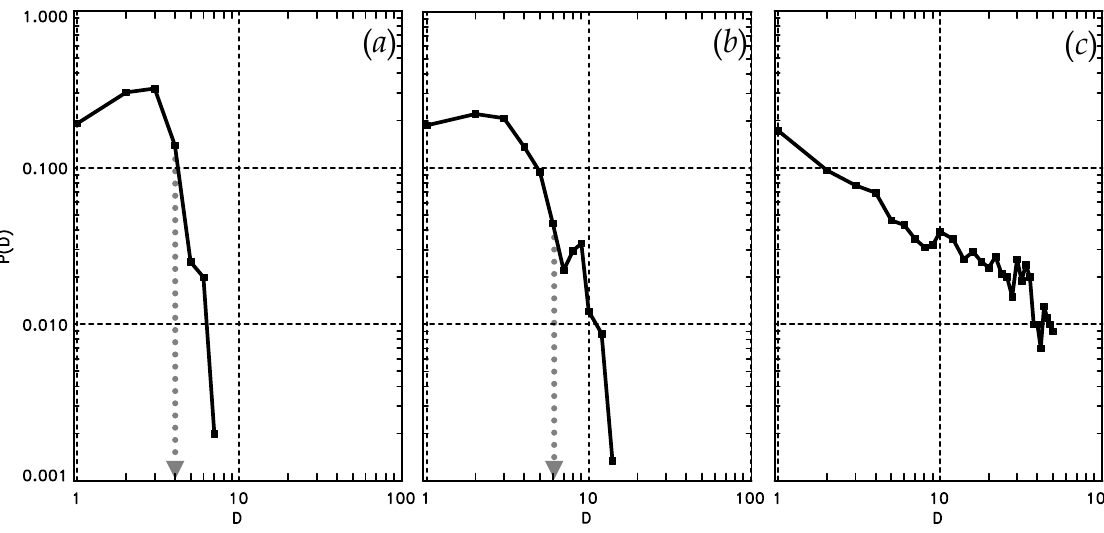
Fig. 3. Distribution functions of D n calculated with NN = 3 for the time series generated by different autonomous dynamical systems. In all three cases M I = M + O = 50. Grey arrows show possible choices of the embedding space dimension. (a) Lorenz attractor ( dt = 0 . 01). Distribution function rapidly drops to zero at D = 3 − 4. (b) Mackey–Glass delay-differential equation ( dt = 0 . 1). Distribution function drops to zero at D = 6 − 7. (c) 1/ f -noise generator. The power shape of the distribution function indicates the absence of finite embedding